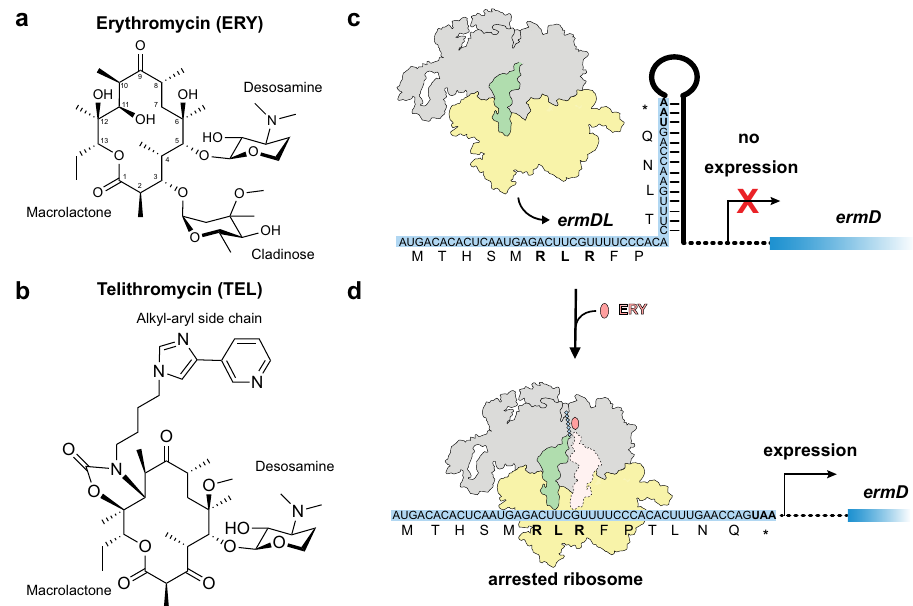
Fig. 1 Macrolide-dependent regulation of ermD expression. a , b Chemical structures of a erythromycin (ERY) and b telithromycin (TEL). c , d Schematic of the ermDL -mediated regulation of the expression of ermD in the c absence and d presence of macrolide